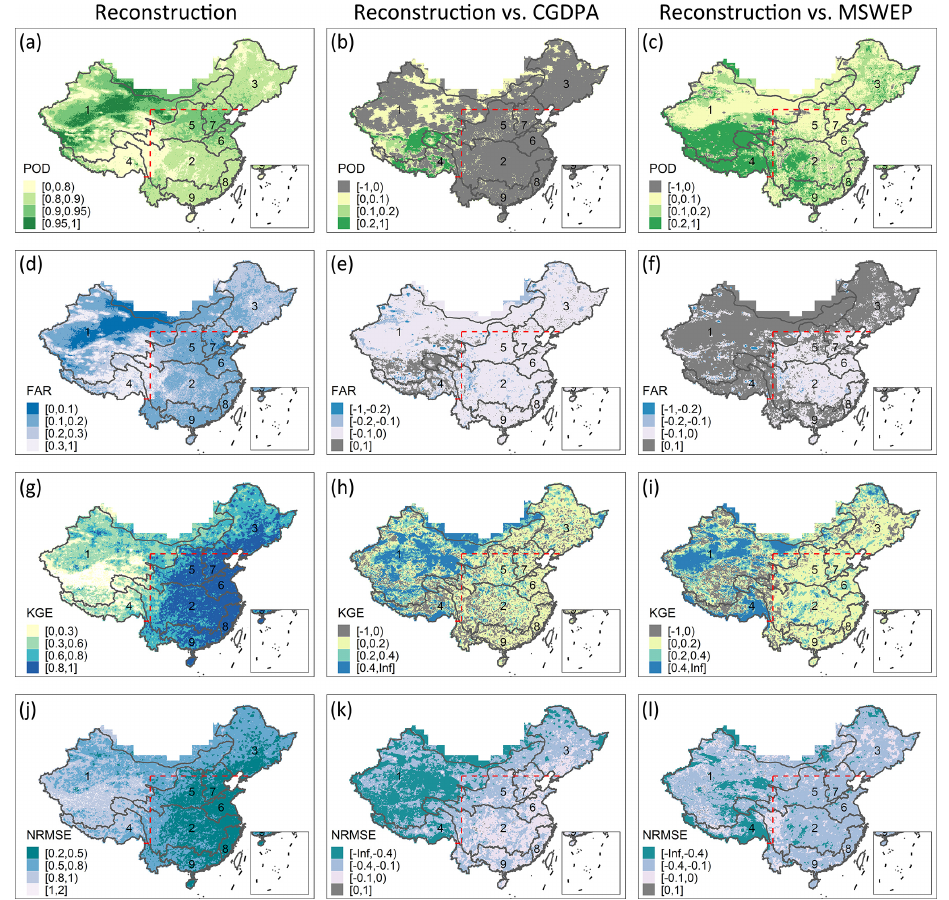
Figure 5. Spatial validation of the reconstructed precipitation. The benchmark dataset is the CMPA. POD: probability of detection, FAR: false alarm rate, KGE: Kling–Gupta efficiency, NRMSE: normalized root mean squared error. The second and third columns are the differences of validated metrics between the reconstructed dataset and the CGDPA and MSWEP datasets. The boundary lines delineate nine major river basins of China: (1) the northwest continental basin, (2) the Yangtze River basin, (3) the Songhua and Liaohe River basins, (4) the southwest basin, (5) the Yellow River basin, (6) the Huaihe River basin, (7) the Haihe River basin, (8) the southeast basin, and (9) the Pearl River basin. In northern (latitude > 40 ◦ N) and western (40 ◦ N > latitude > 27 ◦ N and longitude < 100 ◦ E) China above the dashed lines, only data in May–September are validated.